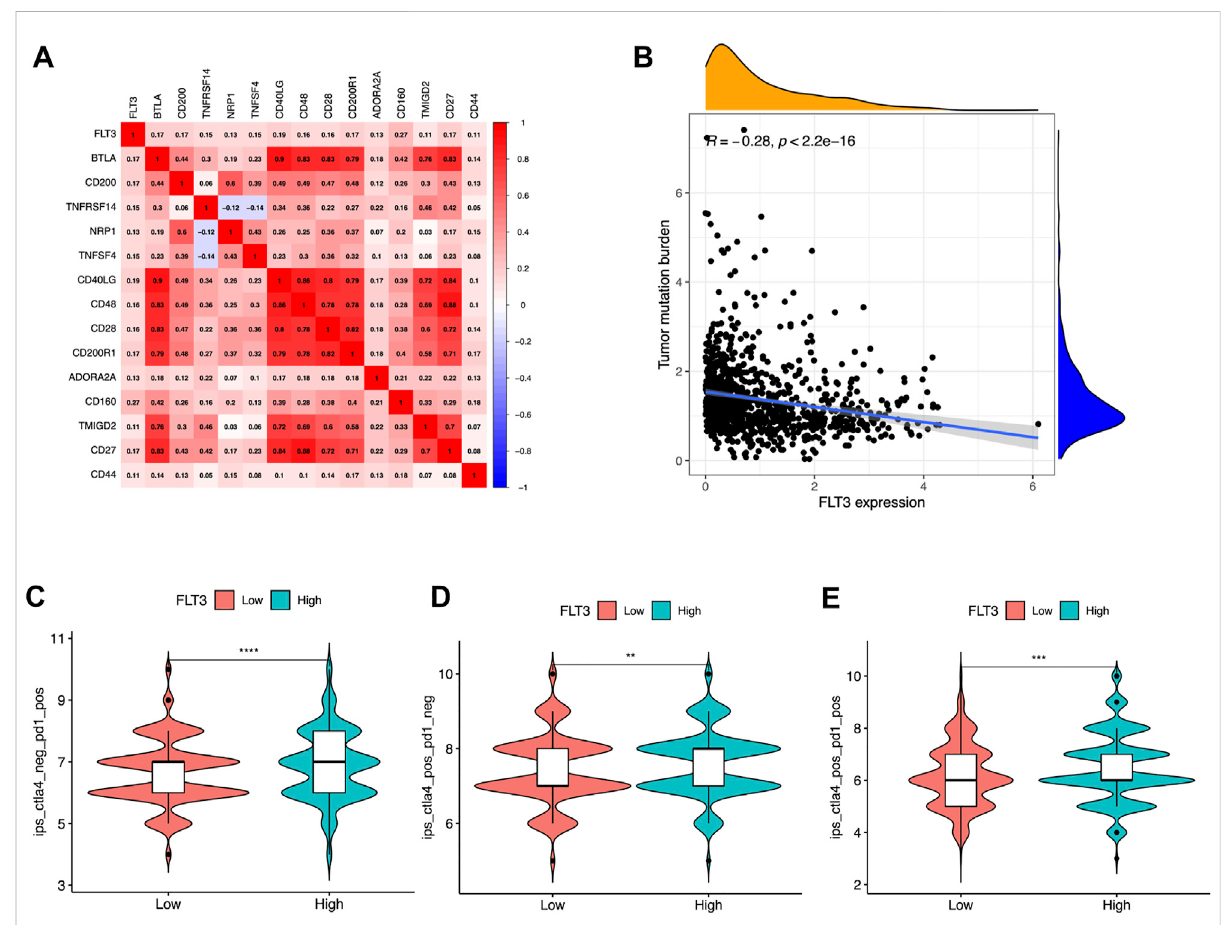
FIGURE 5 AssociationsofFLT3withimmune-relatedgenes. (A) CorrelationsbetweenFLT3andimmunecheckpointmolecules.Redispositive,andblueis negative. The numbers in the circle represented the correlation value and all the p -value < 0.05. (B) Correlation between FLT3 expression and tumor mutation burden. Violin plotsshowing the showing the FLT3 expression between (C) IPS-PD1/PD-L1/PD-L2, (D) IPS-CTLA4, and (E) IPS- CTLA4 and PD1/PD-L1/PD-L2 scores and FLT3 expression in patients of The Cancer Genome Atlas breast cancer. The asterisks represent the statistical p -value (ns: p > 0.05, * p ≤ 0.05, ** p ≤ 0.01, *** p ≤ 0.001, **** p ≤